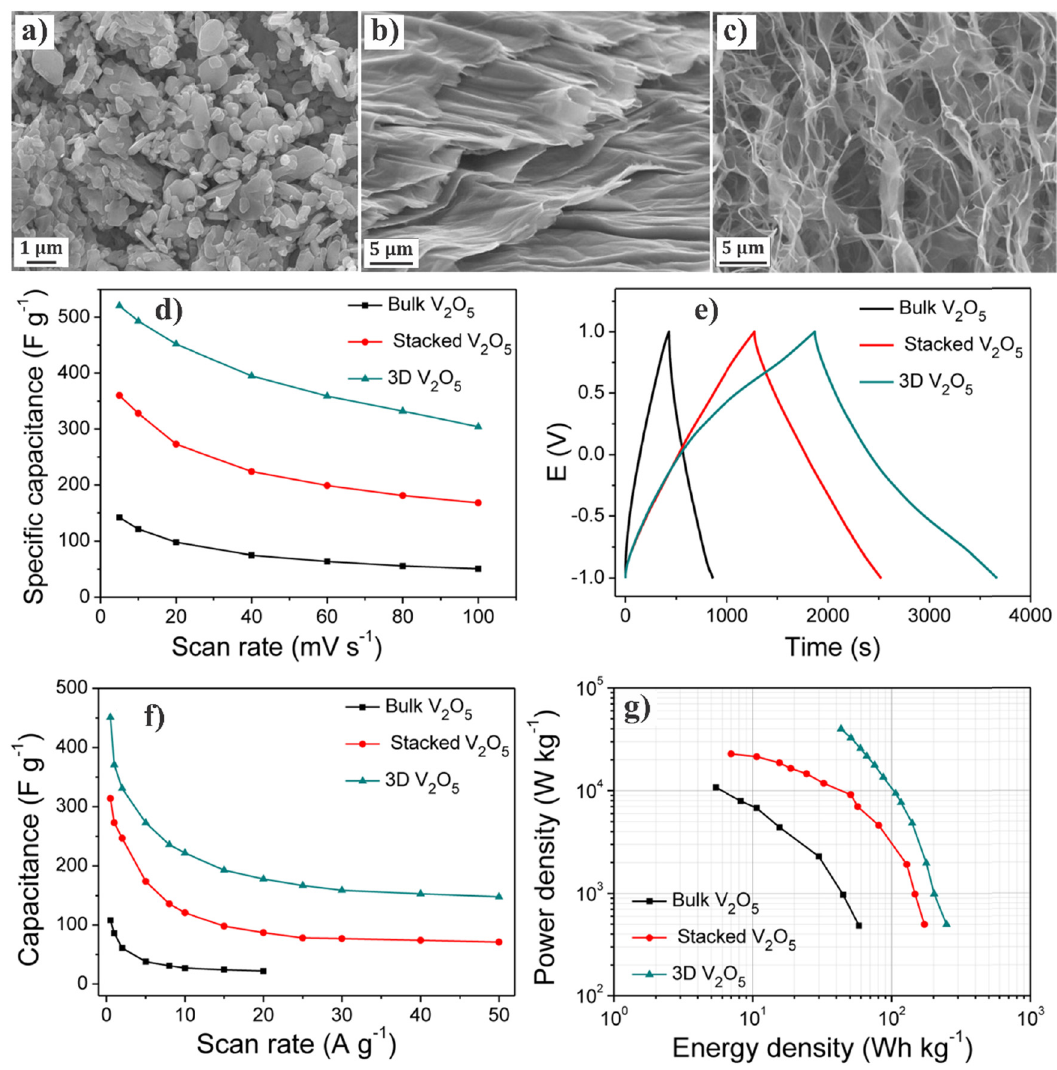
Figure 6: FESEM images of V 2 O 5 : ( a ) commercially available bulk, ( b ) staked fi lms, and ( c ) 3D architecture constructed from ( b ) . Electrochemical performance of 3D V 2 O 5 , staked fi lms, and bulk for supercapacitors: ( d ) speci fi c capacitances calculated from the cyclic voltammetry curves, ( e ) galvanostatic charge/discharge at a current density of 0.5 A g − 1 in the range of − 1.0 to + 1.0 V in Na 2 SO 4 1 mol L − 1 aqueous solution, ( f ) speci fi c capacitances calculated from galvanostatic charge/discharge with various current densities and ( g ) power density and energy density of V 2 O 5 3D architecture, stacked fi lm, and bulk electrodes [ 25 ]